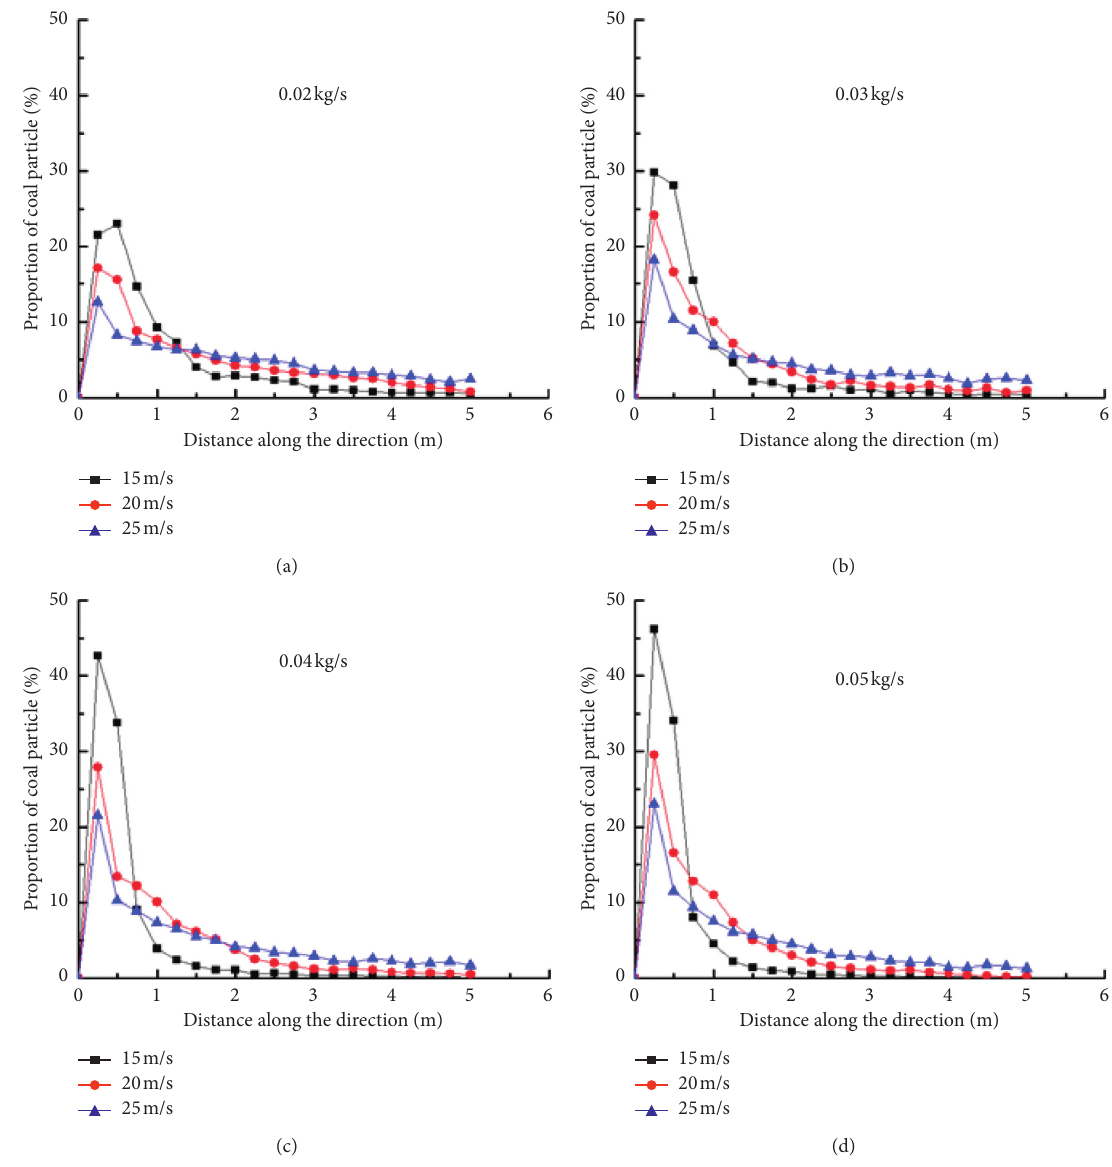
Figure 11: Particle number distribution along the flow